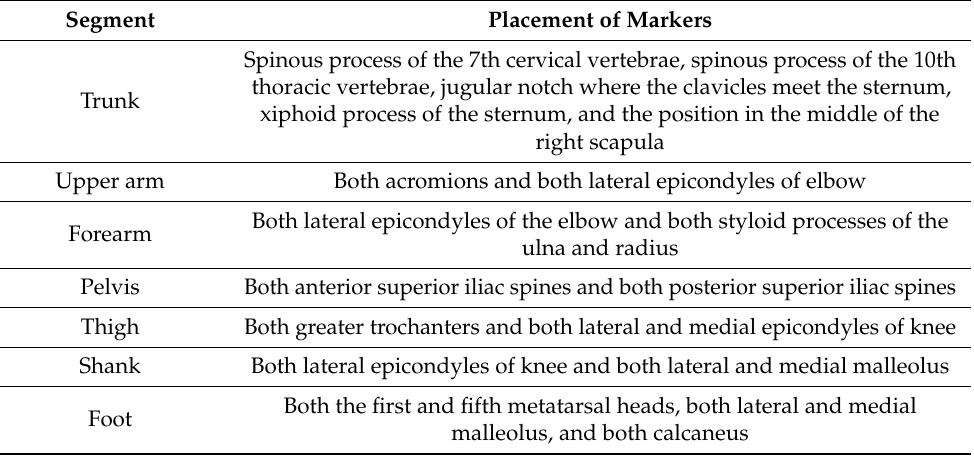
Table 1. Placement of markers on the body that defined the 12 segments of the motion capture kinematic model.